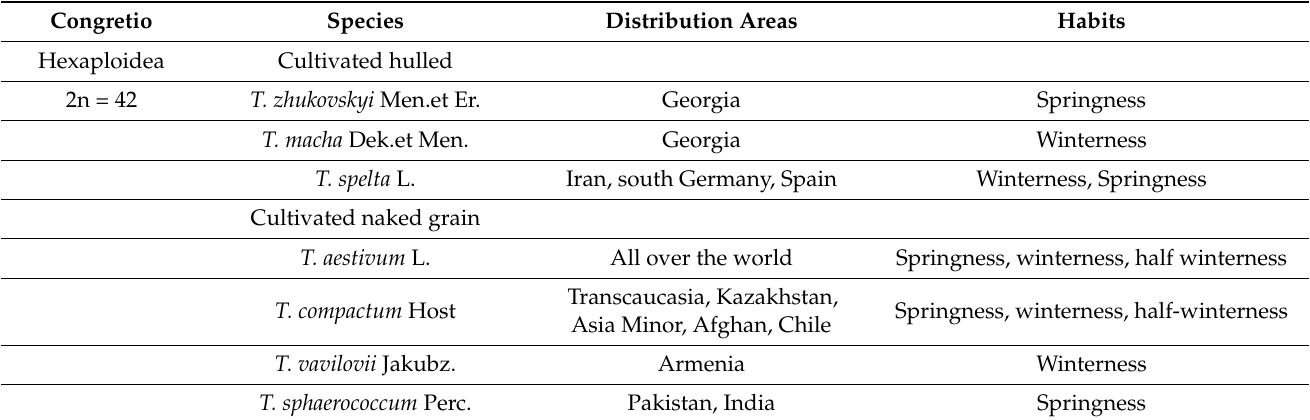
Table 2. Jacubciner’s classification system (1958) According to Yen a. Yang [2]. Congretio Species Distribution Areas